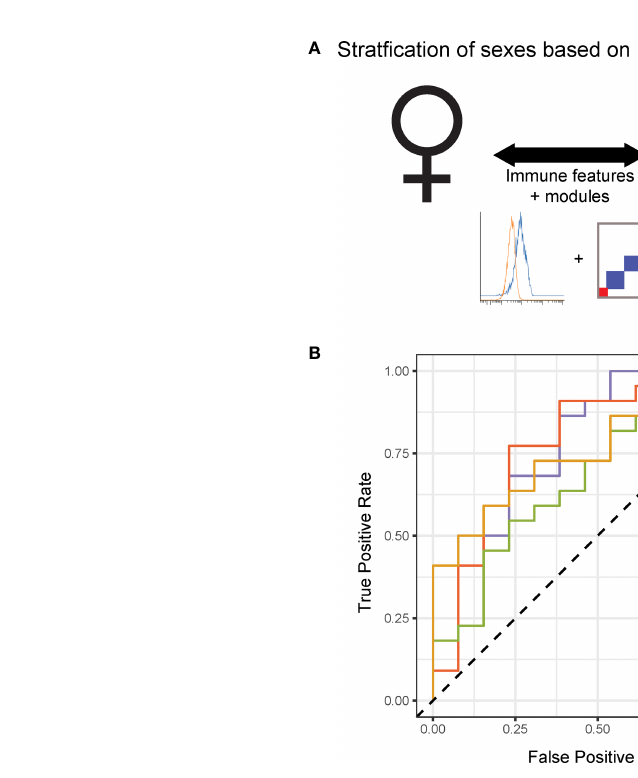
FIGURE 3 | Immune modules enable improved strati fi cation of immune responses across sex and age. (A) Schematic of modeling approach for sex differences. (B) Receiver operating characteristic curve for ridge, lasso, group lasso, and sparse group lasso for prediction of sex based on immune structure. Performances on test data were as follows [stated as percent correct classi fi cation, area under the curve (AUC)]: ridge, 68%, 0.79; lasso, 60%, 0.69; group lasso, 60%, 0.76; sparse group lasso, 74%,